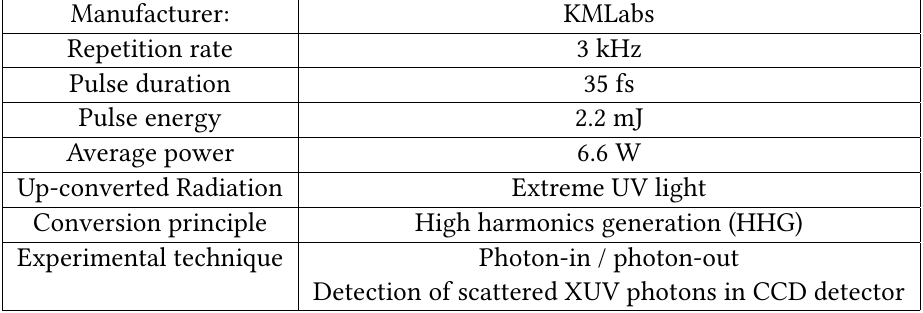
Table 2: Main parameters of Ju